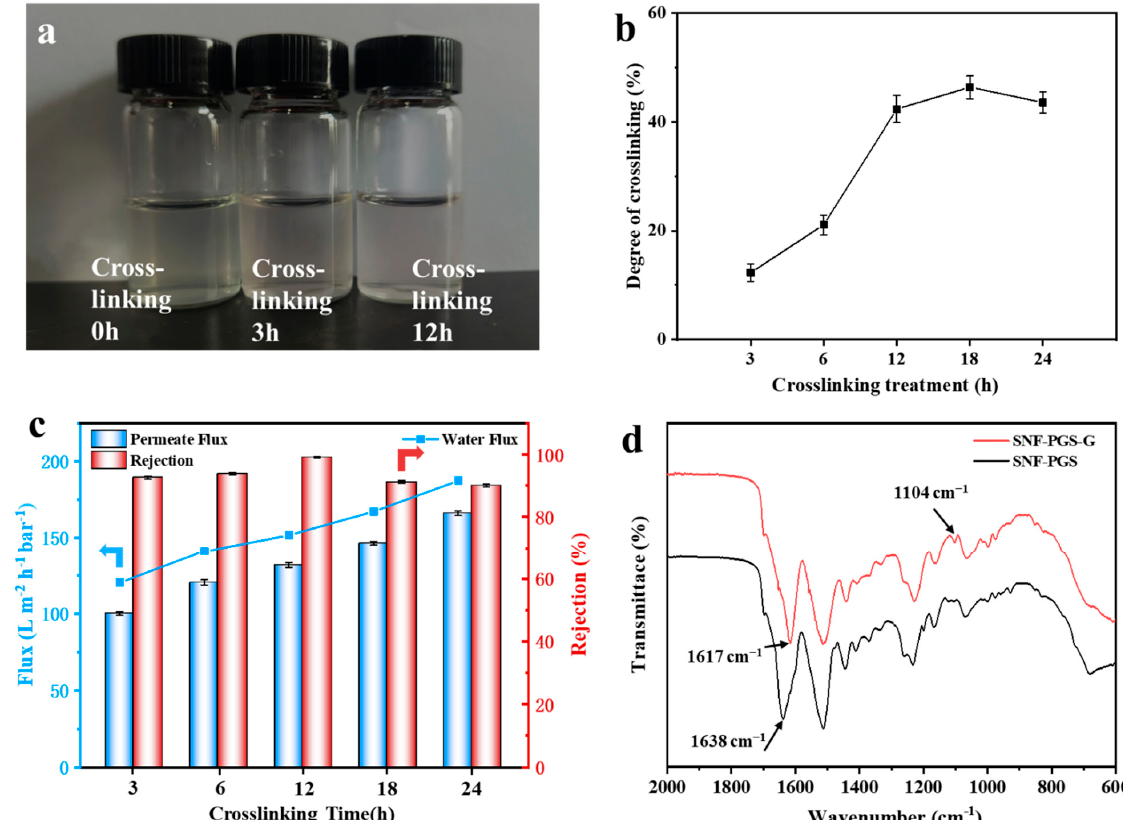
Figure 3. Characterization of SNF-PGS solution and membranes before and after crosslinking: ( a ) visual appearance of SNF-PGS solution for different crosslinking times; ( b ) degree of crosslinking obtained for SNF-PGS solution for the different reaction conditions; ( c ) separation performance of the different crosslinking time of the SNF-PGS (15:1) composite membranes for water and 100 ppm CR solution; ( d ) FT-IR spectrum of SNF-PGS and crosslinked with genipin.